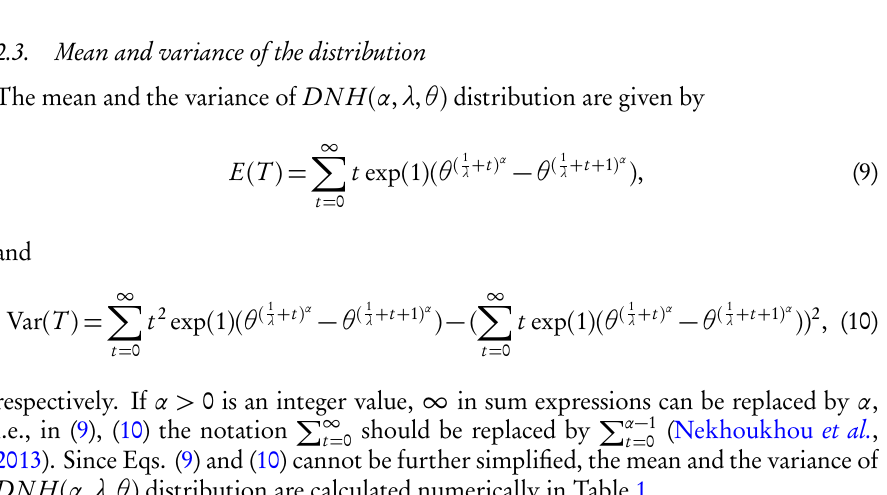
Figure 2 – Comparison of the hazard function of DNH distribution assuming different values of α , λ and θ